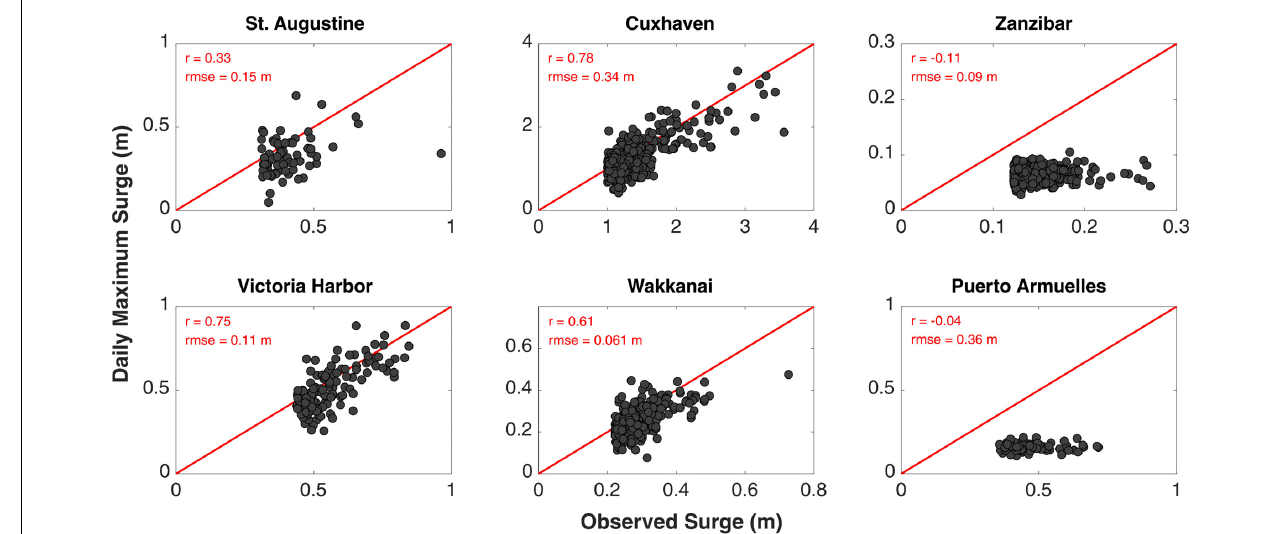
FIGURE 7 | Validation of Model-RS performance for extreme events (surge values above the 95th percentile